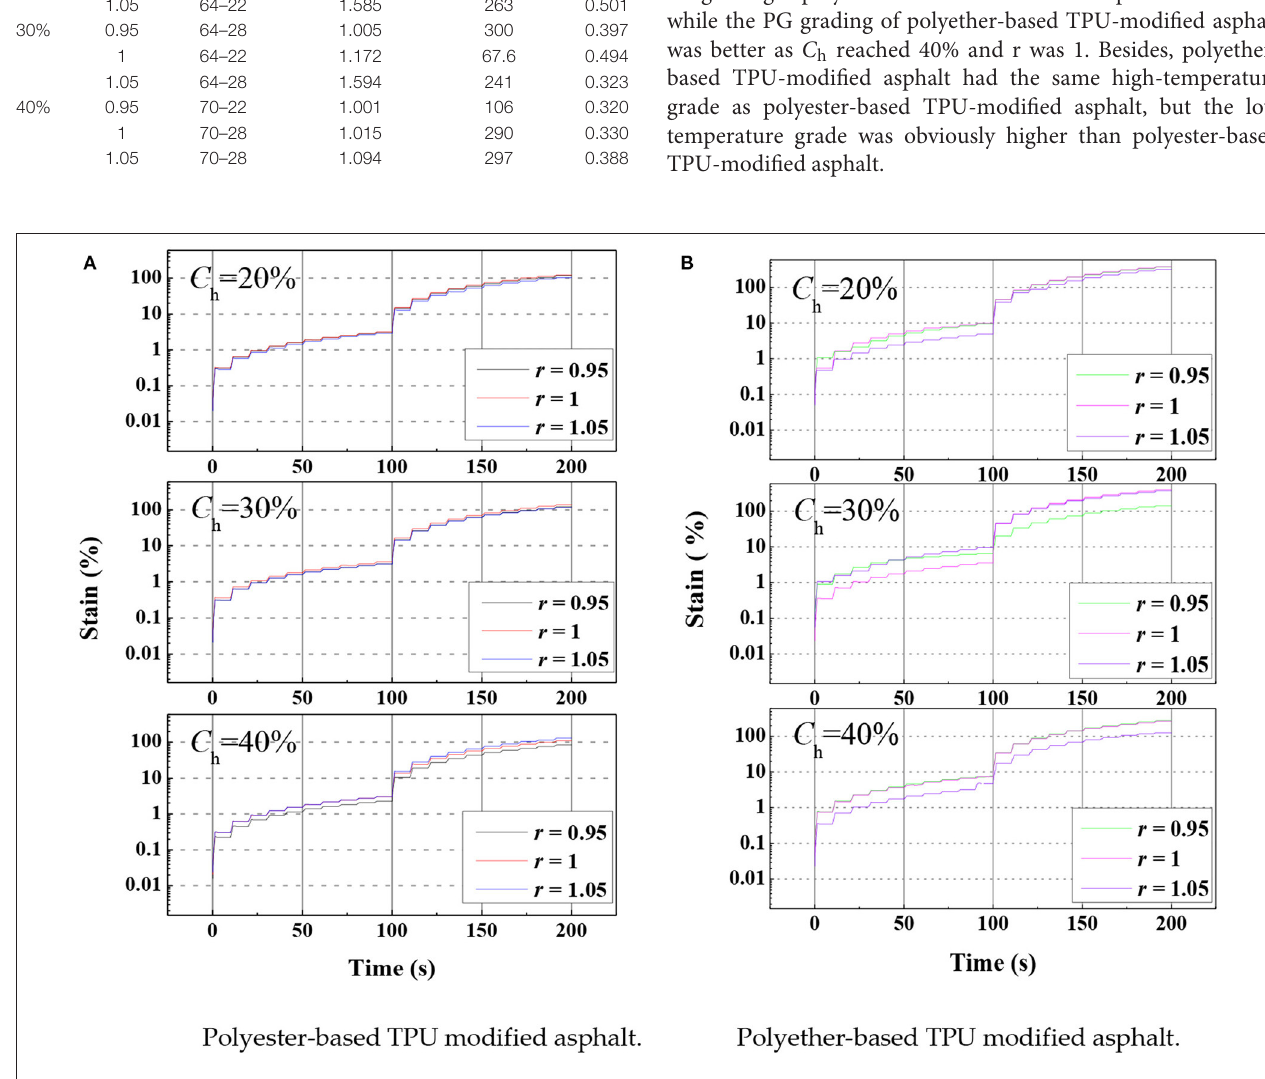
Frontiers in Materials |